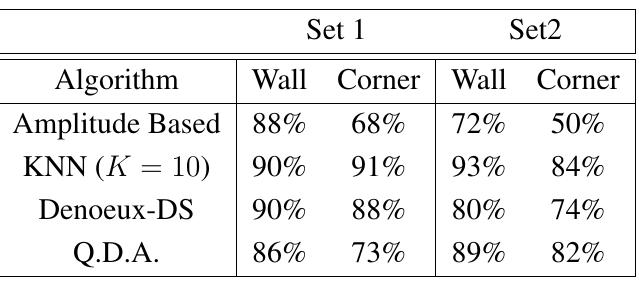
Table 3. Success percentages obtained for different classification algorithms. For distances under 4 m and all incidence